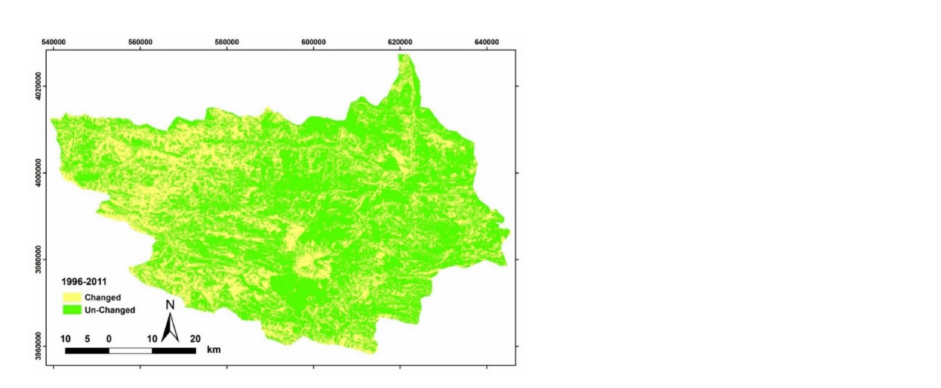
Figure 3. Areas where the land use has changed (yellow) or remained the same (green) between 1996 and 2011. Table 3. Areas and percentages of land-use classes in 1996 and 2011.